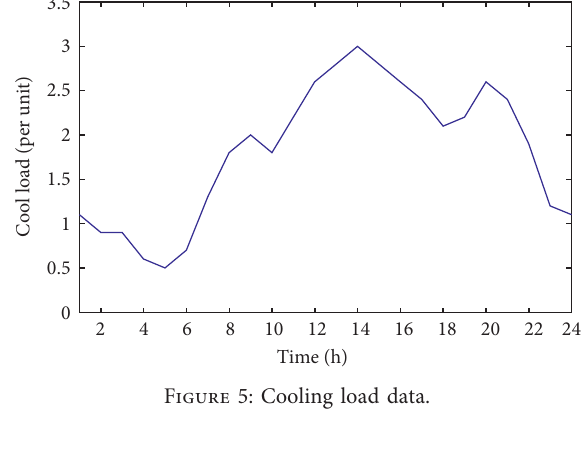
Figure 5: Cooling load